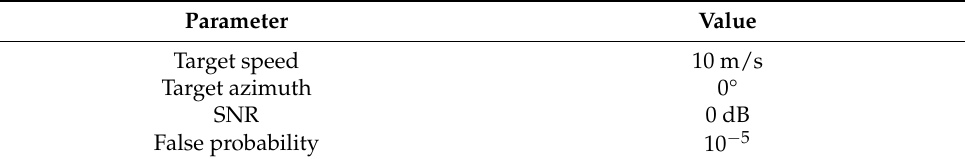
Table 2. Simulation parameters of target.